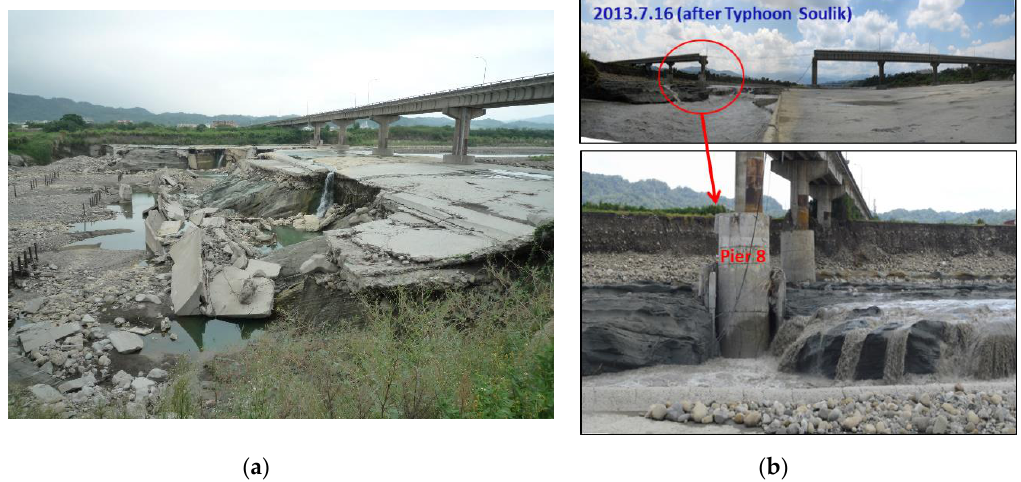
Figure 2. Scour downstream of grade-control structure leading to failure of Zhongzheng Bridge in Touqian River, Taiwan ( a ) scour downstream of grade-control structure in 2009 (courtesy of Yee-Meng Chiew); ( b ) Scour leading to bridge failure in 2013 (courtesy of Dr. Hong JH).